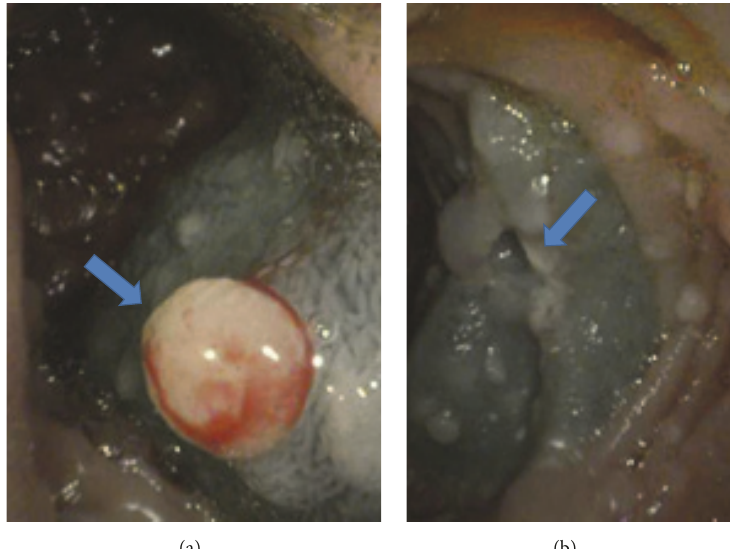
Figure 3: (a)Mucosal lift performed with a solutionof methylene blueand salinein preparation for endoscopic mucosal resection of proximal jejunal polypoid lesion (arrow). (b) Mucosal defect post hot snare resection of proximal jejunal polypoid lesion (arrow).